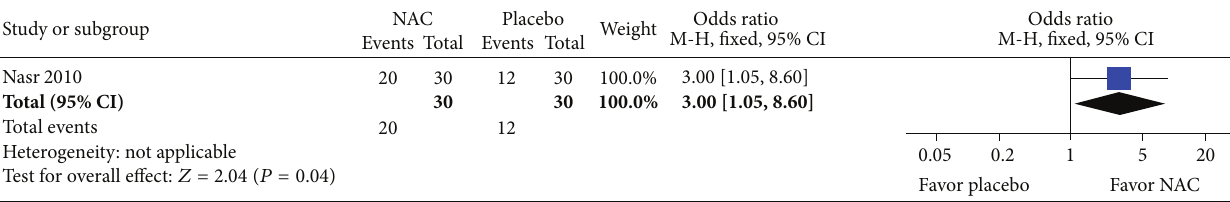
Figure 3: Forest plot: outcome: live birth rate in women with PCOS comparing NAC with placebo.